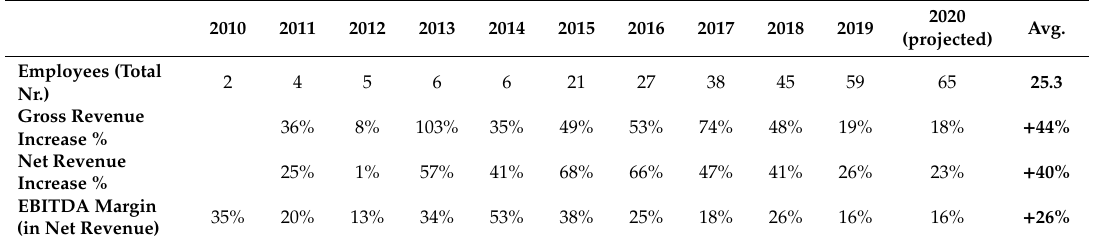
Table 3. Economic Indices and Personnel Employed in Trek 2010–2020.